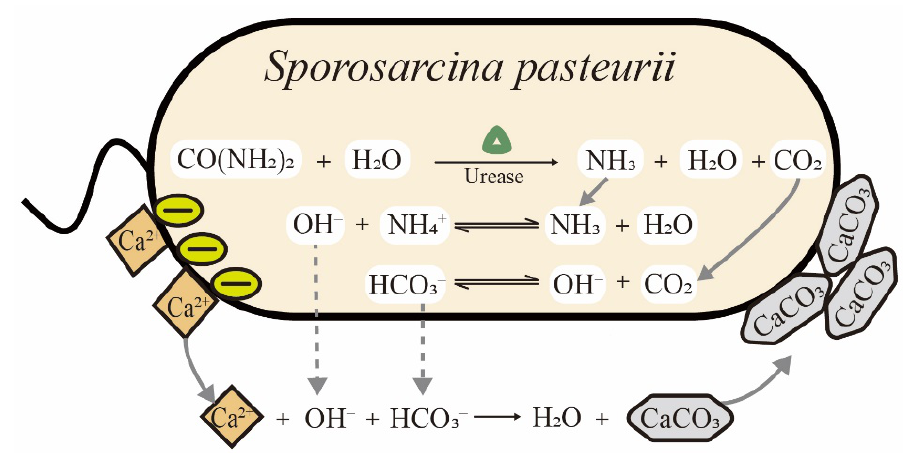
Figure 1. Schematic of microbially induced calcite precipitation (MICP) catalyzed by S. pasteurii cells.